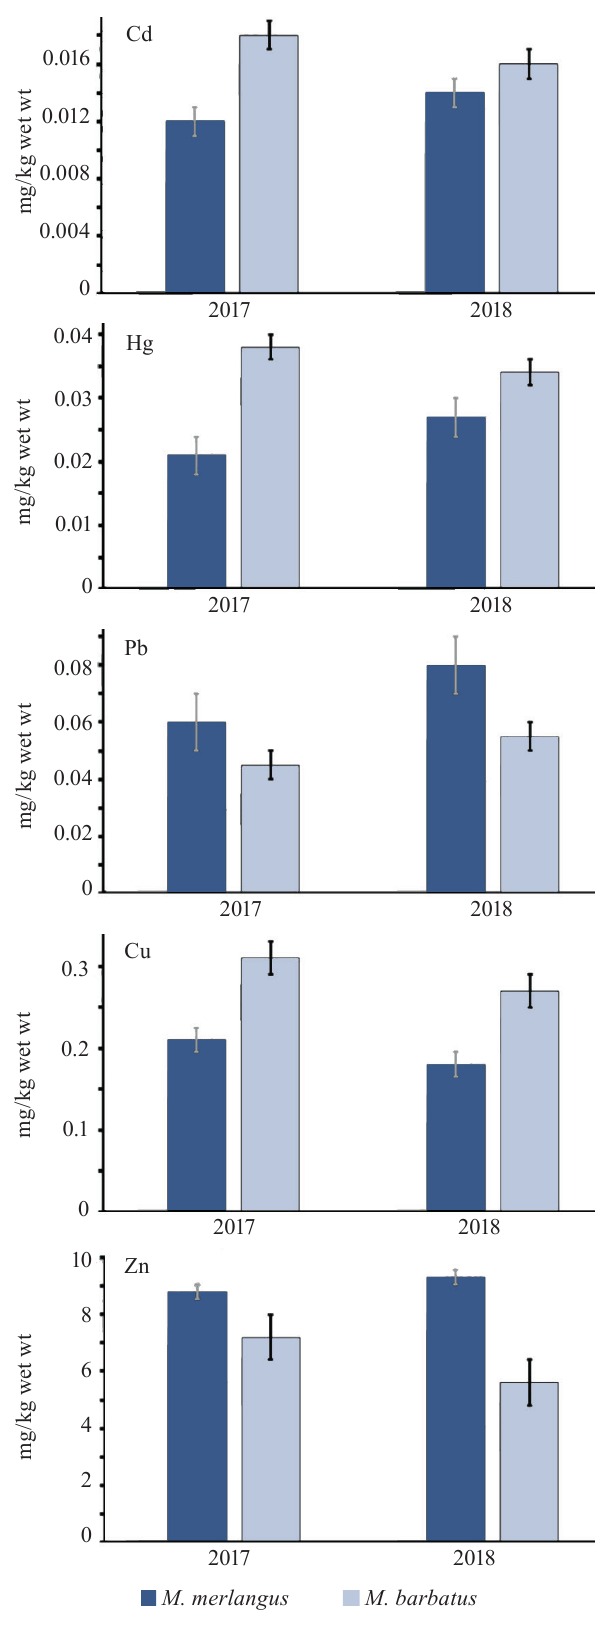
Figure 2 Heavy metal amounts with standard deviation for Cd, Hg, Pb, Cu, and Zn in the edible tissues of M. merlangus L. and M. barbatus L. from the Black Sea coasts caught in 2017 and